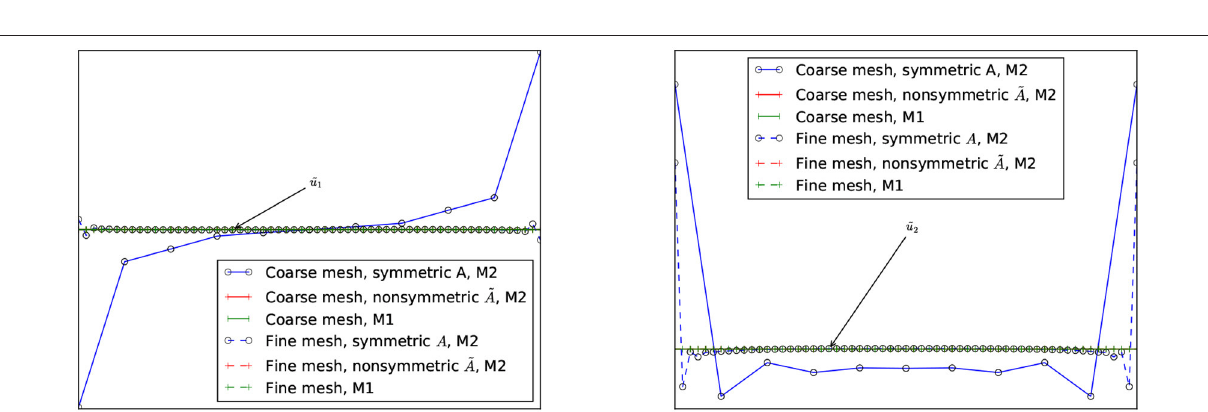
contact. The shorter rectangle (cid:127) 1 , located below, has dimensions ( L 7 + L 8 + L 9 ) × h 1 , see Table 3 for lenght values. Vertical